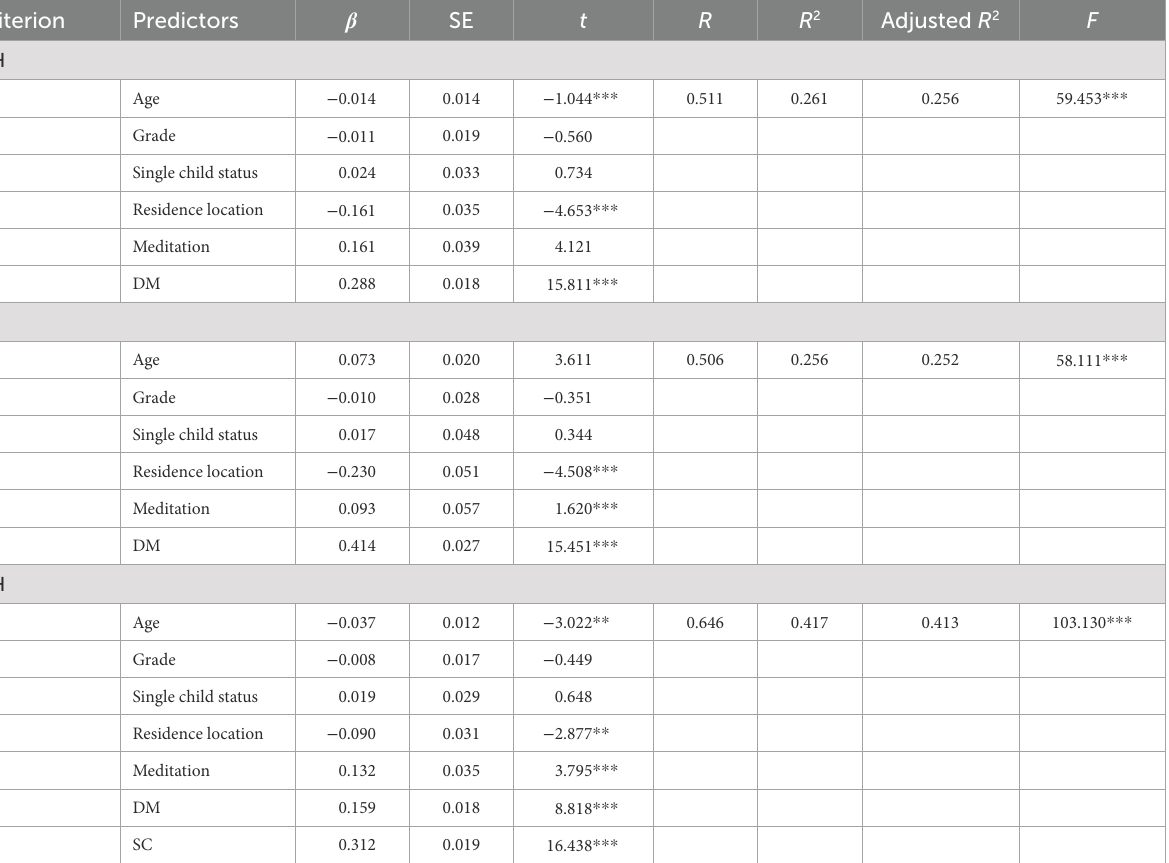
TABLE 3 Testing the mediation role of